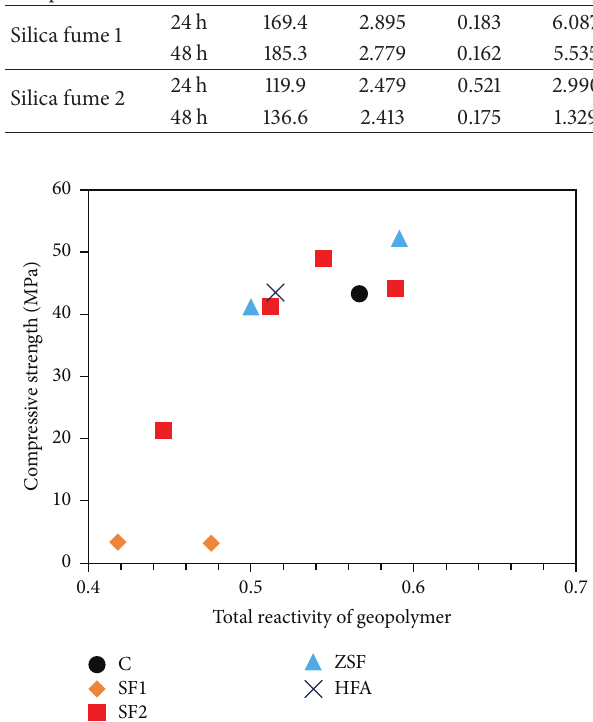
Figure 7: Relationship between compressive strength and total reactivity of fly ash-slag